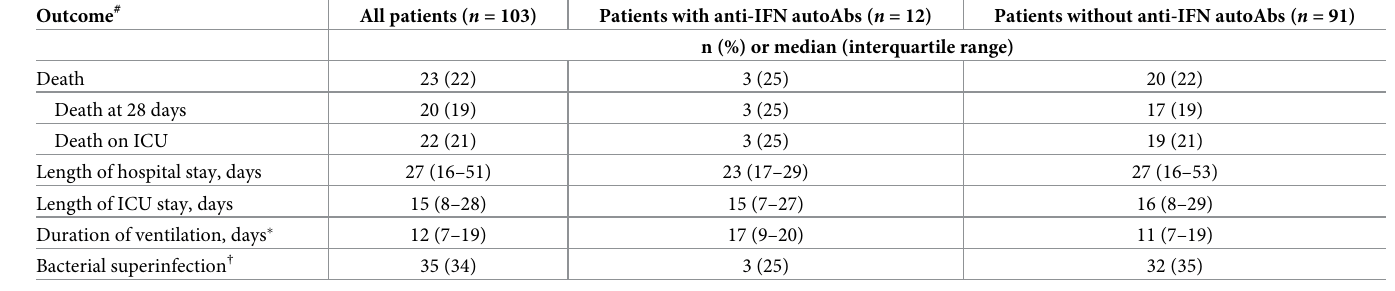
Table 2. Description of patient